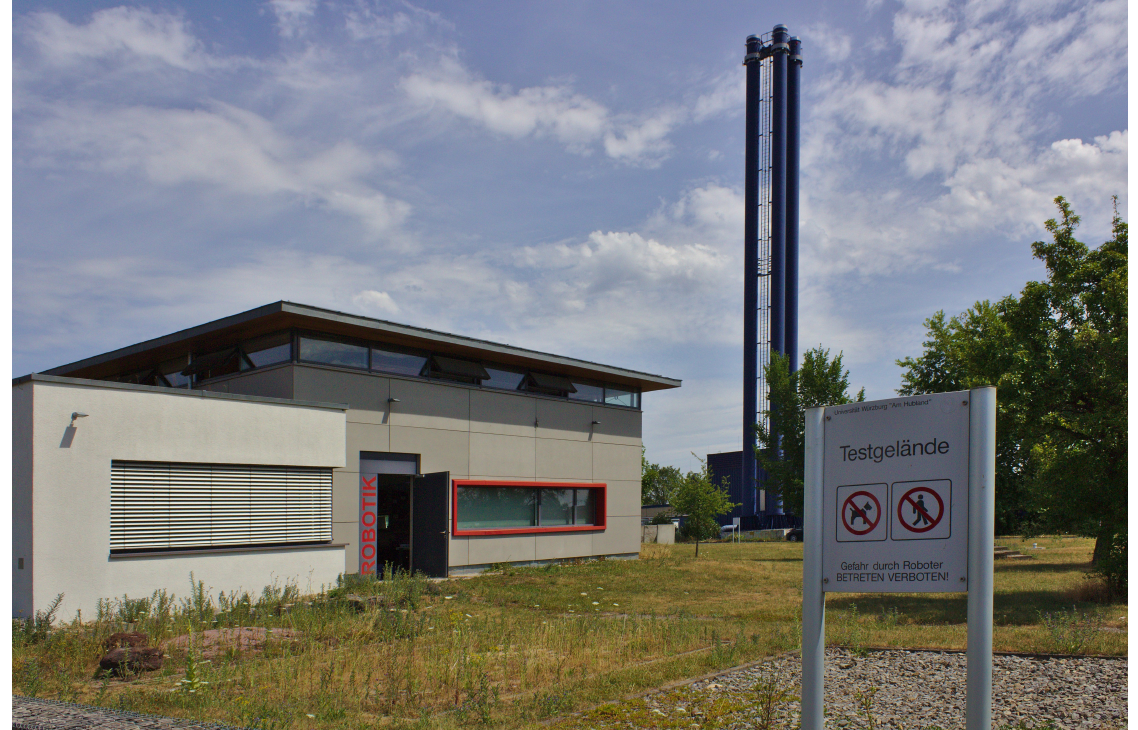
Figure 19. The robotics hall and the robotic test field were the experiment took place. In the foreground, the areas for simulating different planetary surfaces. In the background, the chimney of the Technischer Betrieb of the